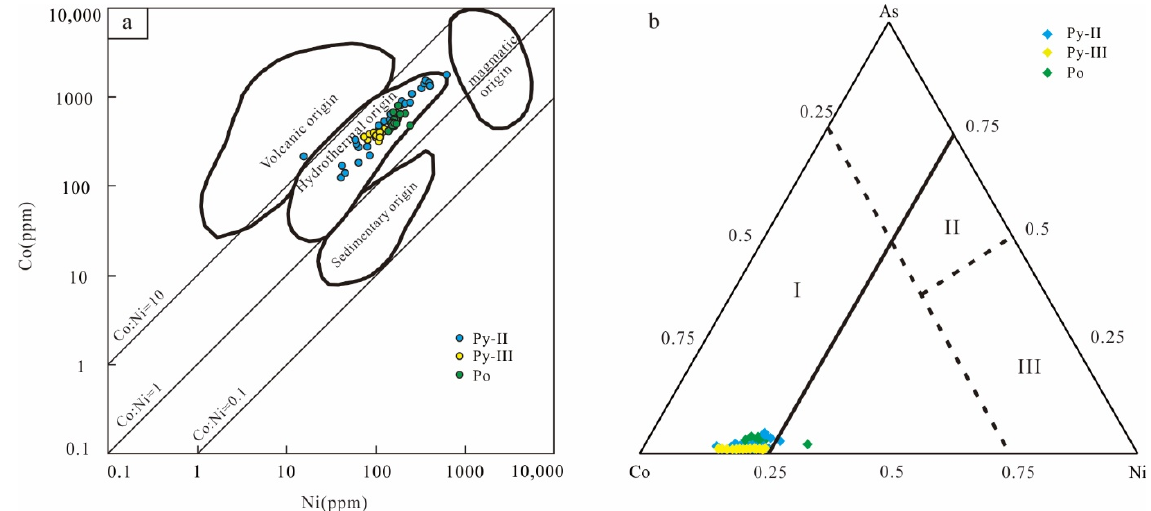
Figure 9. ( a ) Co-Ni discriminant diagram (after Bralia et al. [100]); ( b ) Co-Ni-As discriminant diagram (I-magmatic hydrothermal type; II-Carlin type; III-metamorphic hydrothermal type, after Yan et al. [93]).